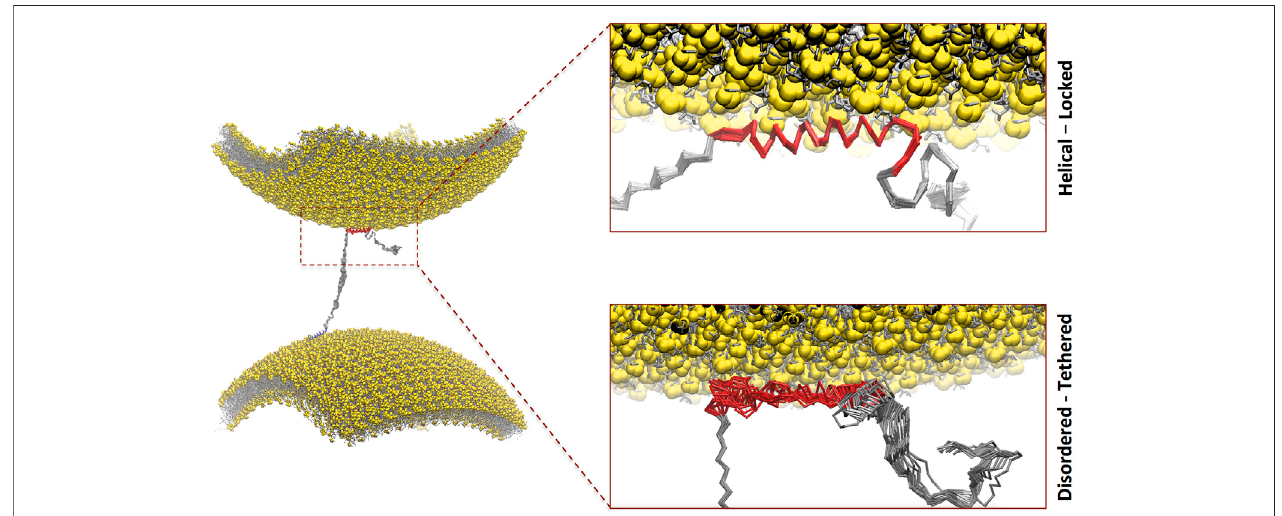
FIGURE1| Double-anchormechanismbywhichonemoleculeof α Sbindsacrosstwovesicles.Inparticular, α Sinteractswitha fi rstvesicle(lowerintheplot) via the N-terminalanchoradoptinganamphipathic α -helicalconformation(blue)andasecondvesicle(upperintheplot) via theregion65 – 97(red).Thepresentstudyfocusedon the conformational dependencies of membrane interaction in the region 65 – 97 by studying the binding via helical-locked (top insert) and disordered-tethered (bottom insert) conformations.